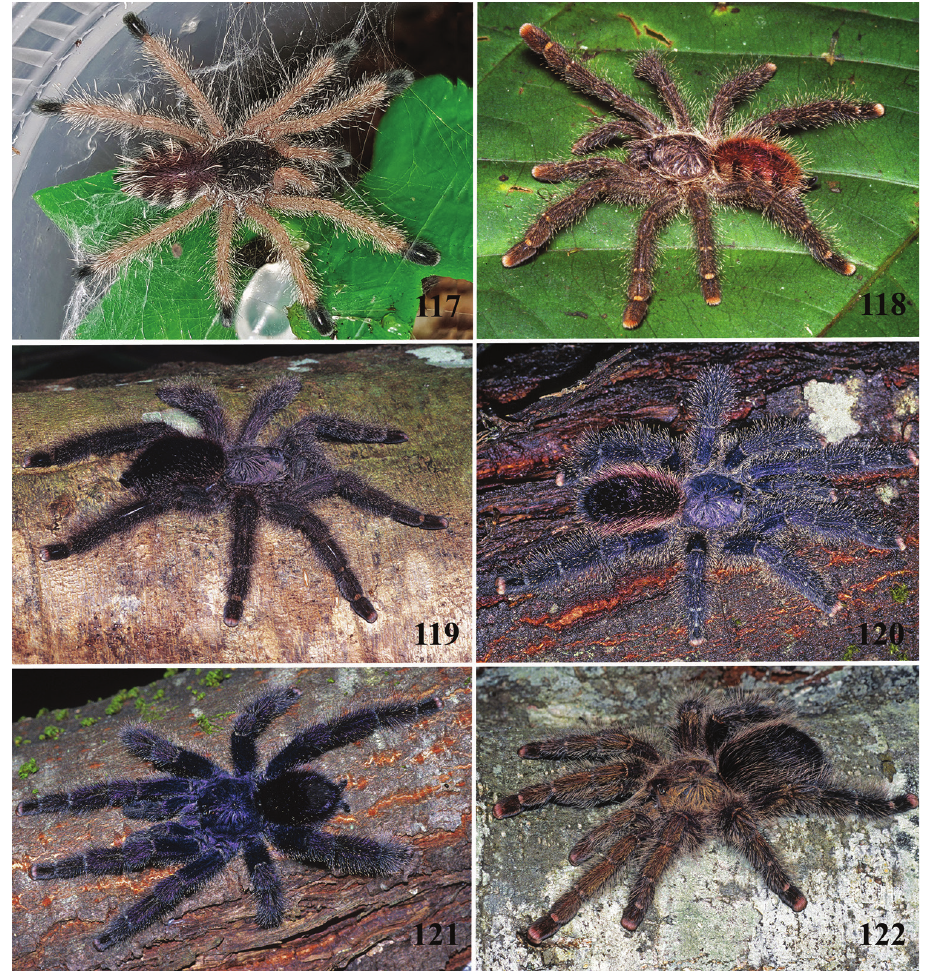
Figures 117–122. Avicularia juruensis Mello-Leitão, 1923, habitus. 117–118 morphotype 2 117 im- mature 118 juvenile 119 female with yellowish leg ring, department of Napo, Ecuador 120 female with whitish leg ring, department of Loreto, Peru 121 male, department of Loreto, Peru 122 morphotype 1, female, Peru. Photos: 117 Tanya Stewart; 118 W. Lamar; 119–122 R. C.